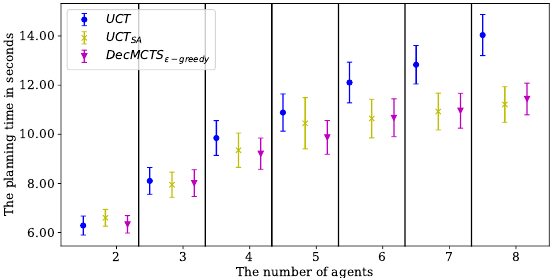
Figure 18. The average running time per decision step in Large warehouse problem over the number of agents for iterative rollout algorithm. The whiskers show the standard